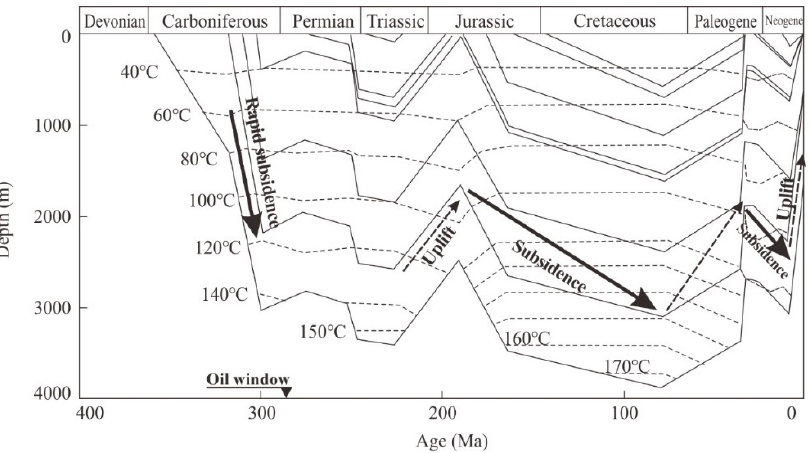
Figure 6. Burial and thermal history of well Chaiye 2 (modified after Wang et al. [10]).